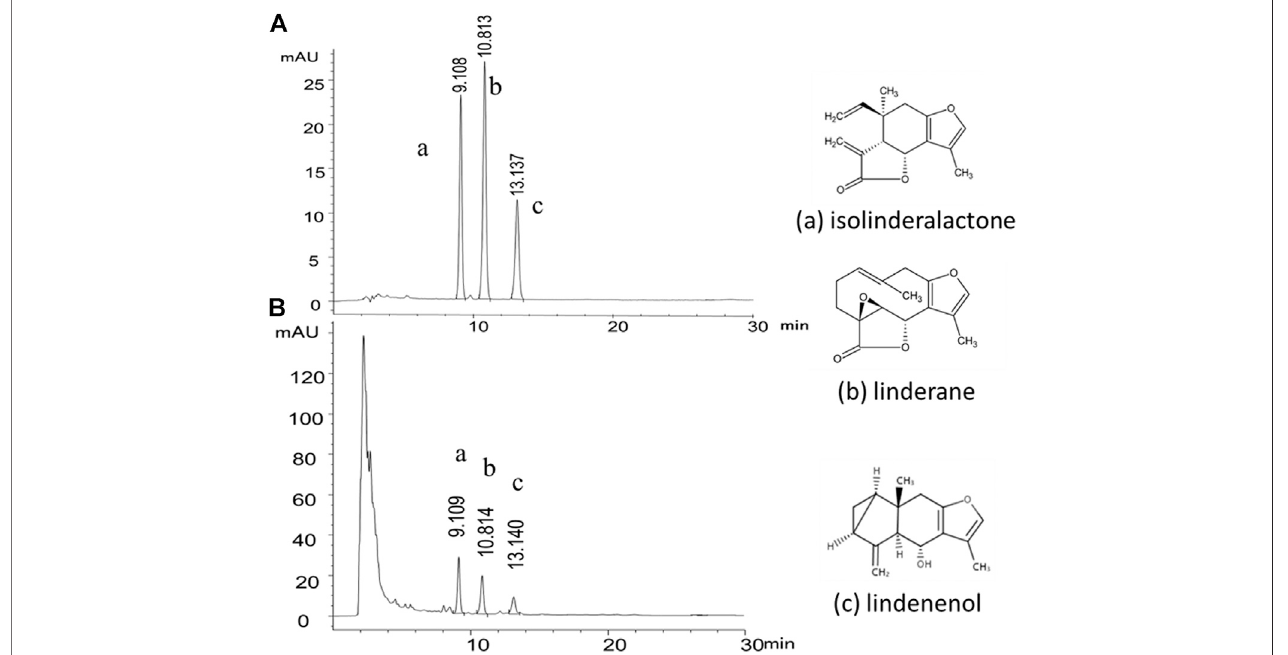
FIGURE 1 | Representative HPLC-DAD chromatogram of the chemical standard and the sample of Linderae Radix ethanol extracts (LREE). (A) The mixed reference substance of isolinderalactone (a), linderane (b) and lindenenol (c). (B) The sample of Linderae Radix ethanol extracts